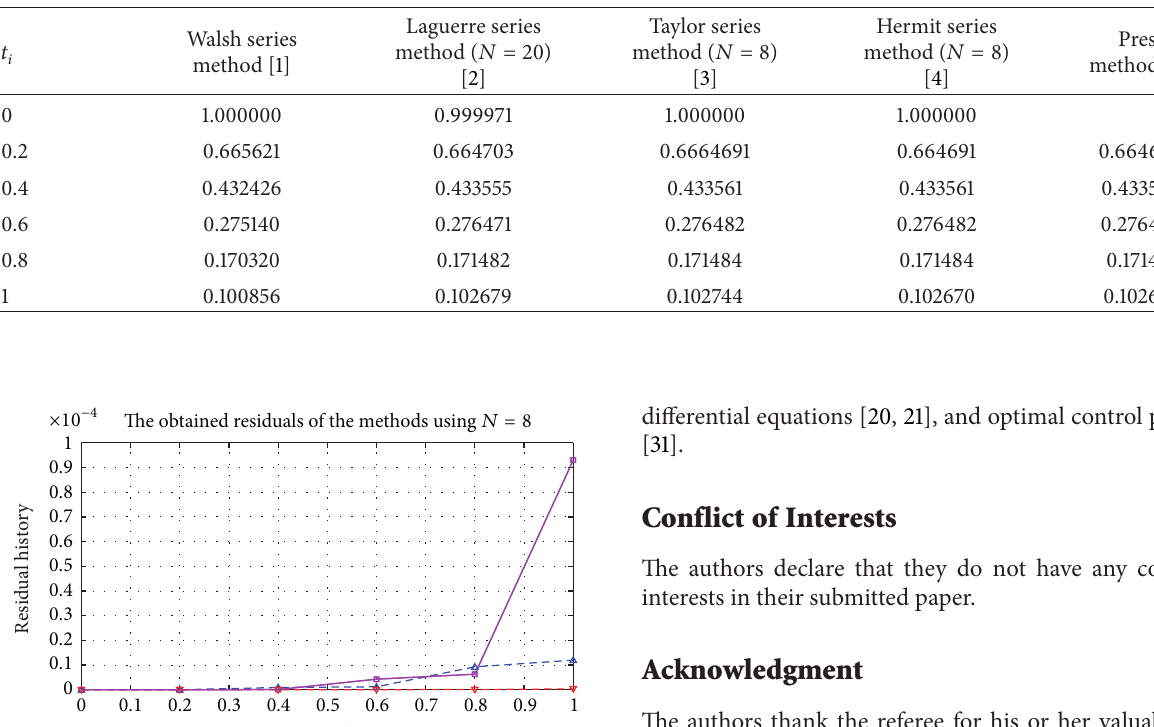
Table 2: Comparison between solutions obtained by the present method and the other methods in Example 5.